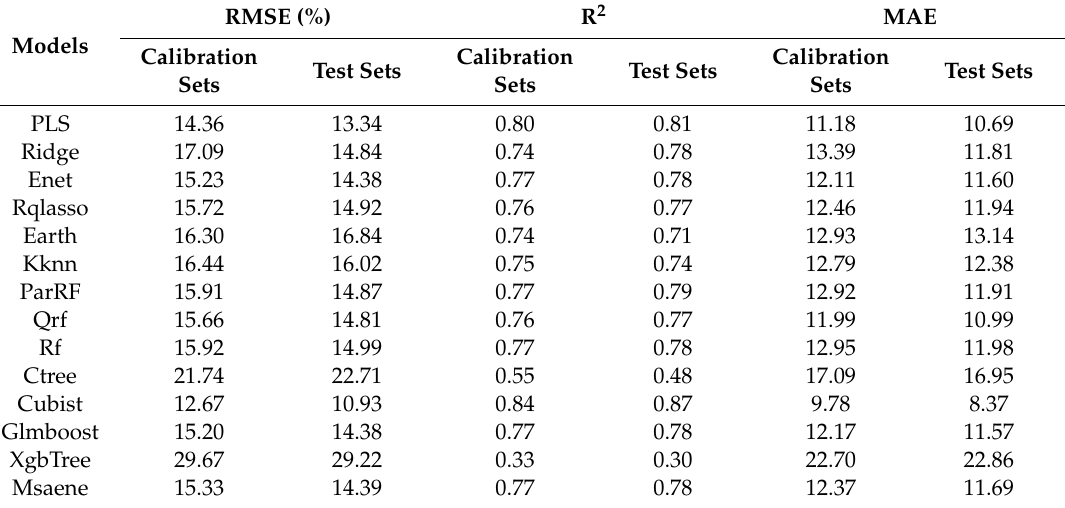
Table 4. Performance comparison of di ff erent machine learning